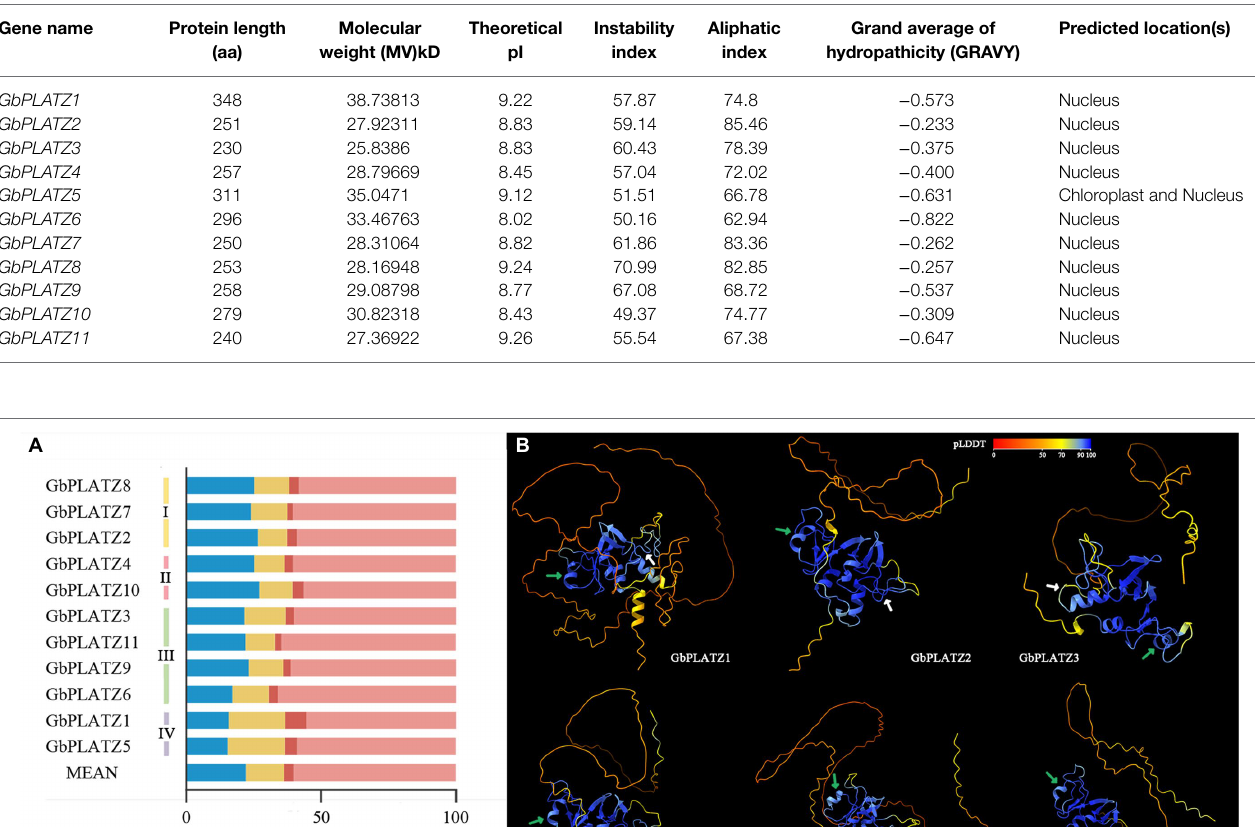
TABLE 2 | Physicochemical properties of GbPLATZs